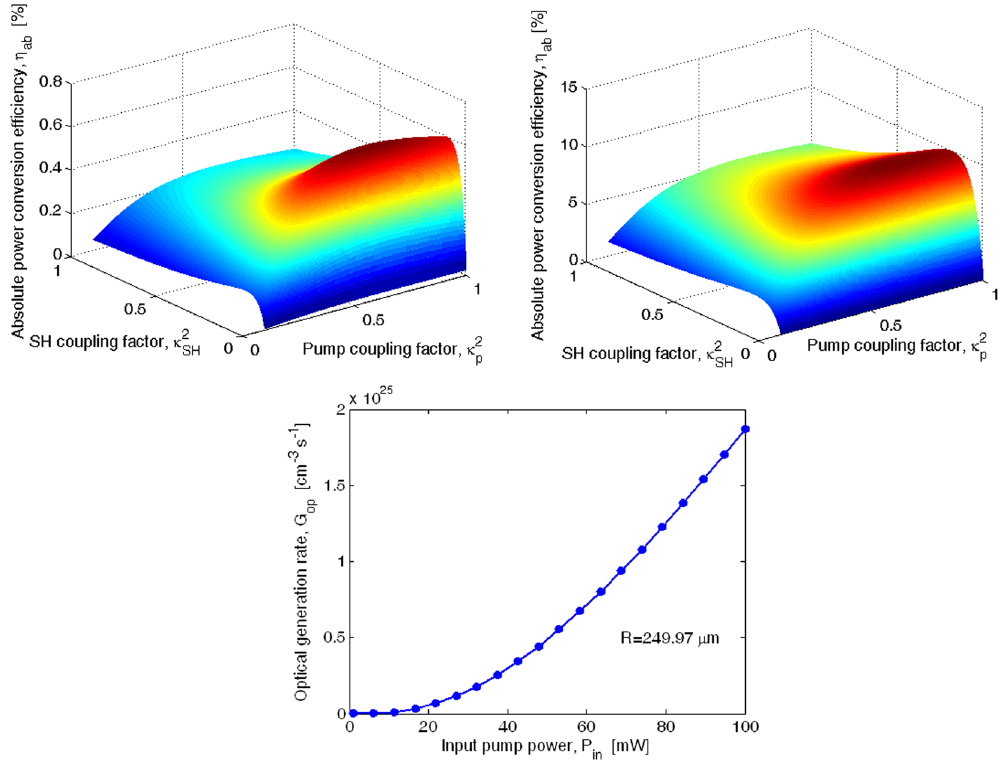
Figure 6. Absolute power conversion efficiency as a function of the pump and SH coupling factor: ( a ) P in = 1 mW. ( b ) P in = 25 mW. ( c ) TPA-induced optical rate generation as a function of the input pump